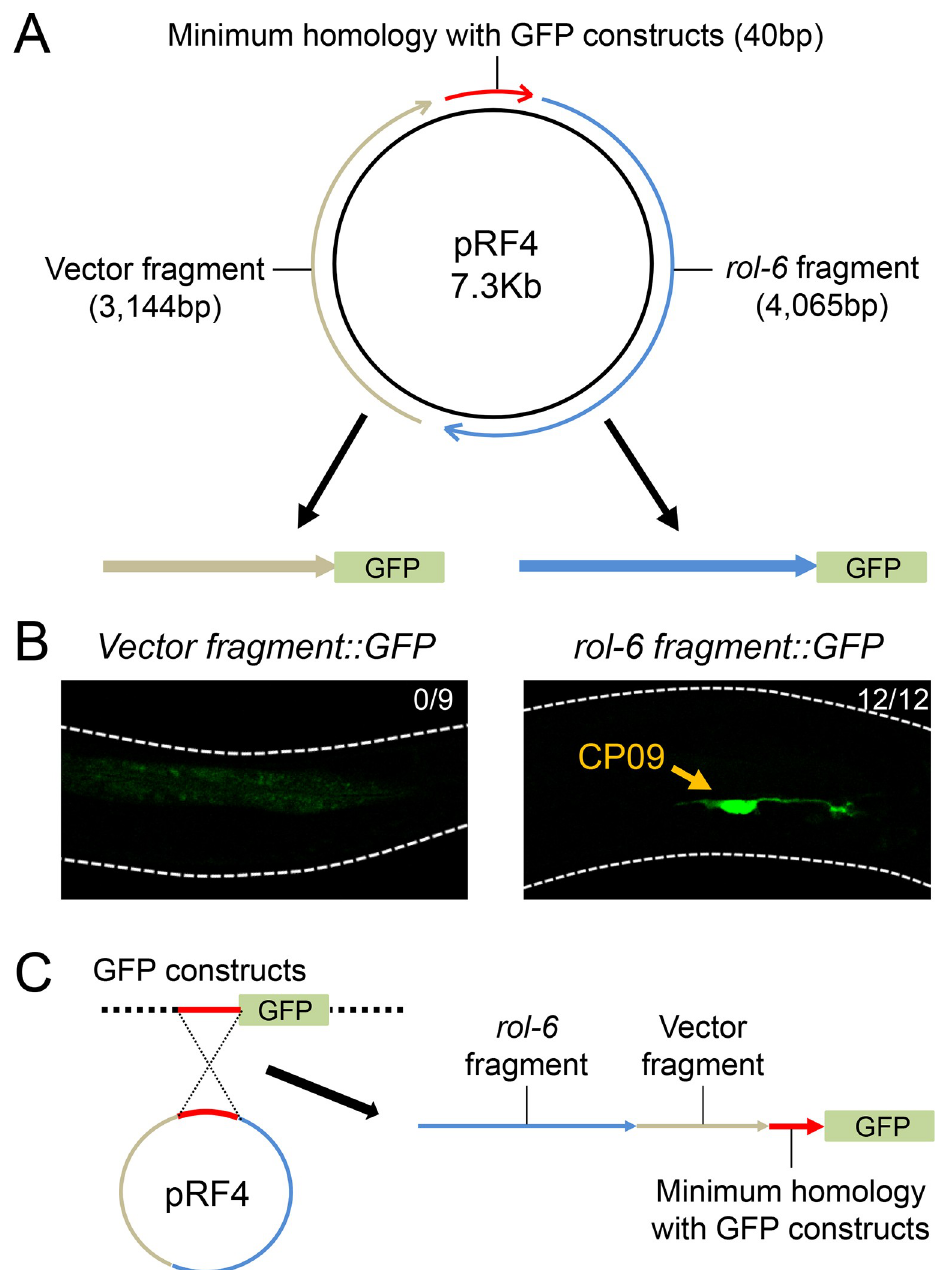
Fig 3. The rol-6 fragment of pRF4 is responsible for CP09 expression. (A) Schematic of cloning procedure to identify a region of pRF4 plasmid responsible for CP09 expression. Either rol-6 or vector fragment was subcloned into the empty GFP vector pPD95.75 and the resulting plasmids were injected to generate transgenic worms. (B) CP09 expression was observed in all 12 independent transgenic lines injected with rol-6 fragment :: GFP (12/12), whereas no CP09 expression was observed in nine independent lines with vector fragment :: GFP (0/9). (C) Proposed model of homologous recombination between pRF4 plasmid and GFP